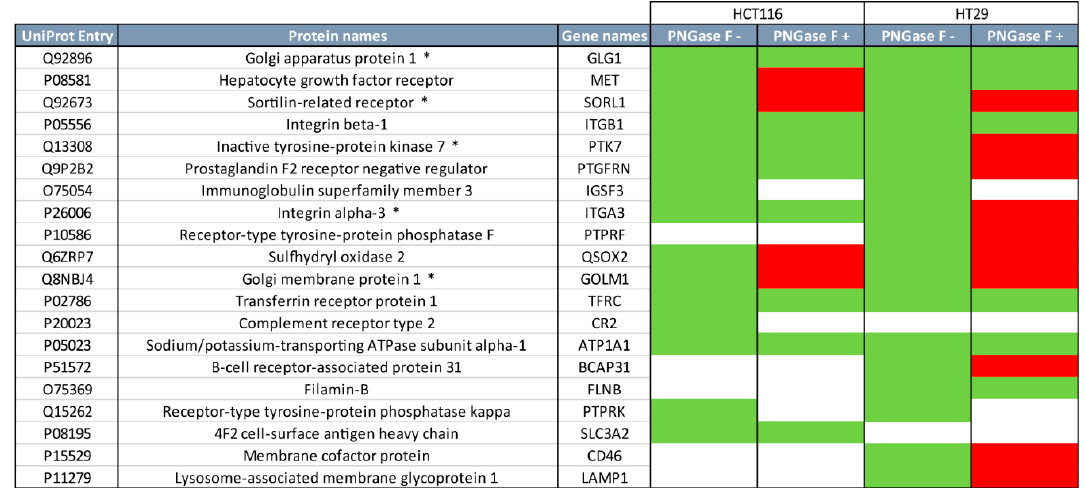
Figure 2. Release of N -glycans reduces the MGL-binding of proteins from CRC cell lines. MGL pull-downs were performed after N -glycan release of the total protein extracts of HCT116 and HT29 cells. Bound proteins were analyzed by SDS-PAGE, trypsin digestion and LC-MS / MS. The top 20 MGL-binding proteins that we previously identified [16] are shown (in green, PNGase F − (white indicates not identified in that cell line)). After N -glycans release (PNGase F + ) MGL binders maintained (green) or lost (red) the ability to bind to MGL. *: proteins with previous [16] identification of glycopeptides with a LacdiNAc epitope on an N -glycan. See Table S1 for further